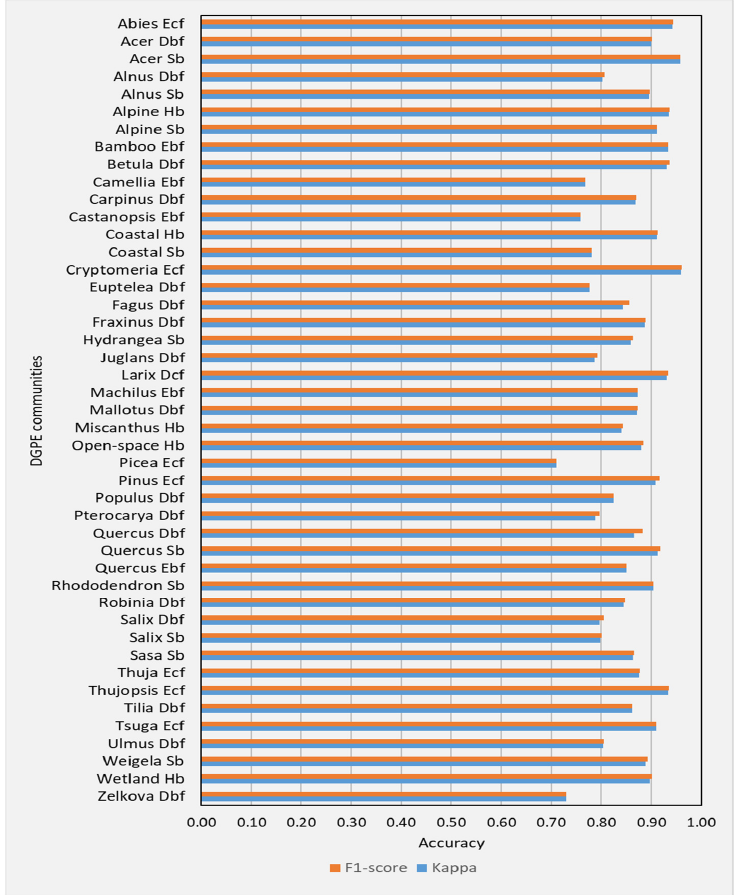
Figure 5. Class wise mean F1-score and Kappa coefficient values calculated for the classification of DGPE communities across 1000-run of bootstrap resampling.